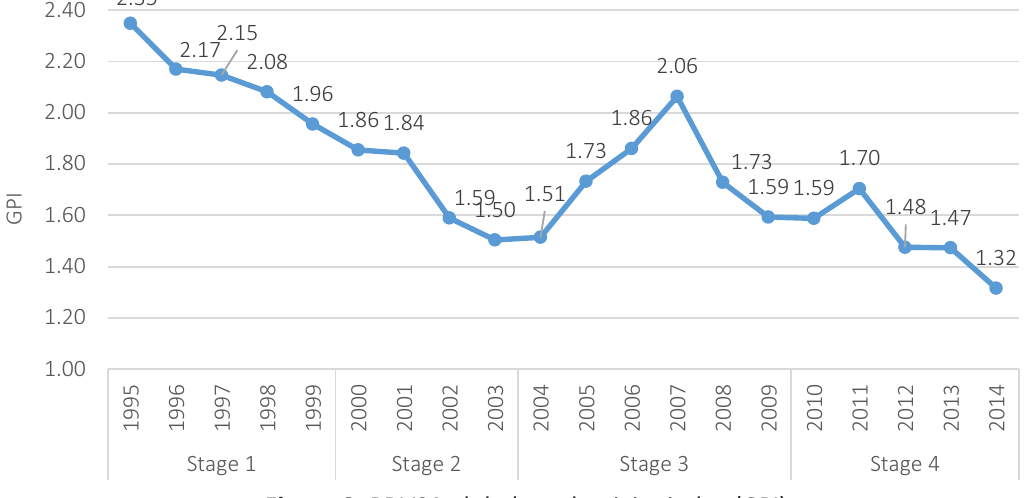
Figure 3. PDVSA global productivity index